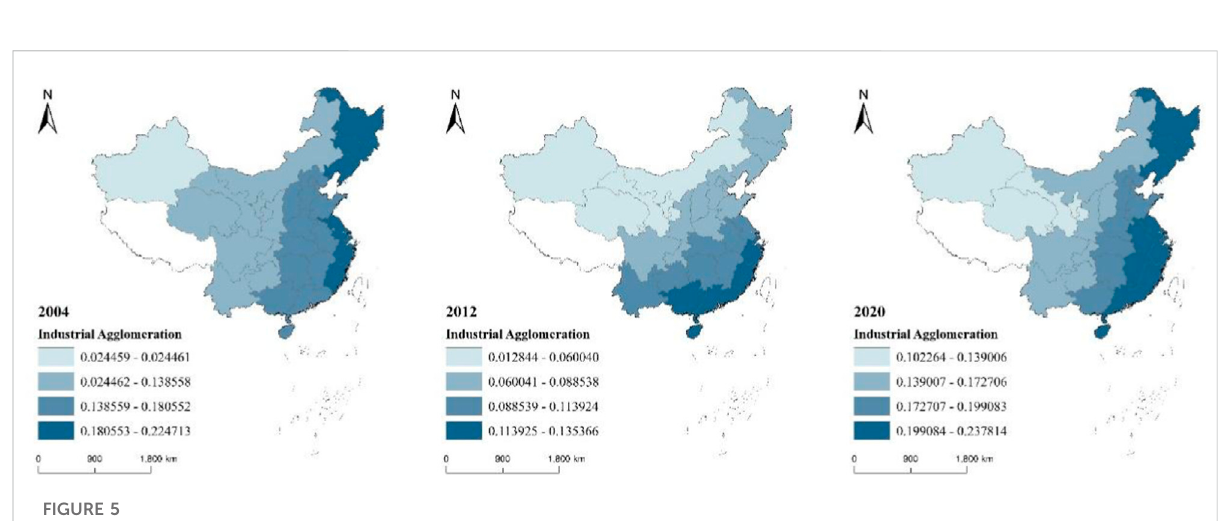
FIGURE 4 Regression coef fi cients for economic output.